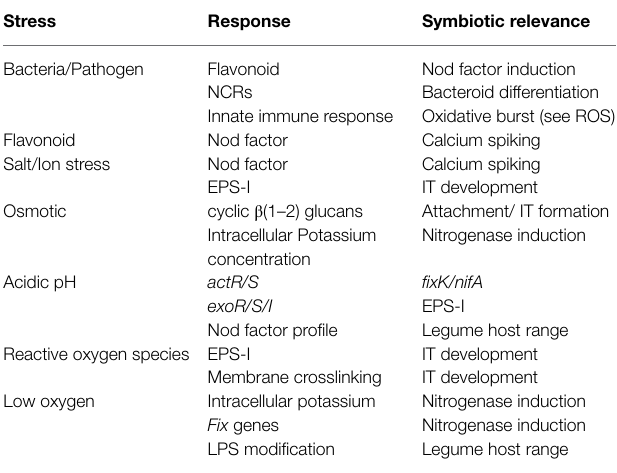
TABLE 1 | Bacterial and plant changes due to perceived stress and their role in